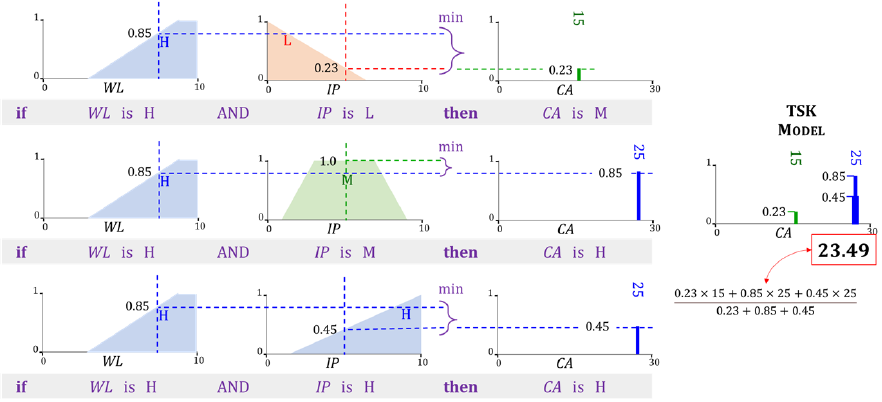
Figure 11. TSK FIS. The inputs to the FIS in Figure 9 are WL = 7.5 and WL = 5.0 (dotted vertical lines), and the output is y = 23.49. The first three rules in Figure 9 with WL = H are ignored since µ L ( 7.5 ) = 0 ) . In the other rules, the values of v B k are 15, 25, and